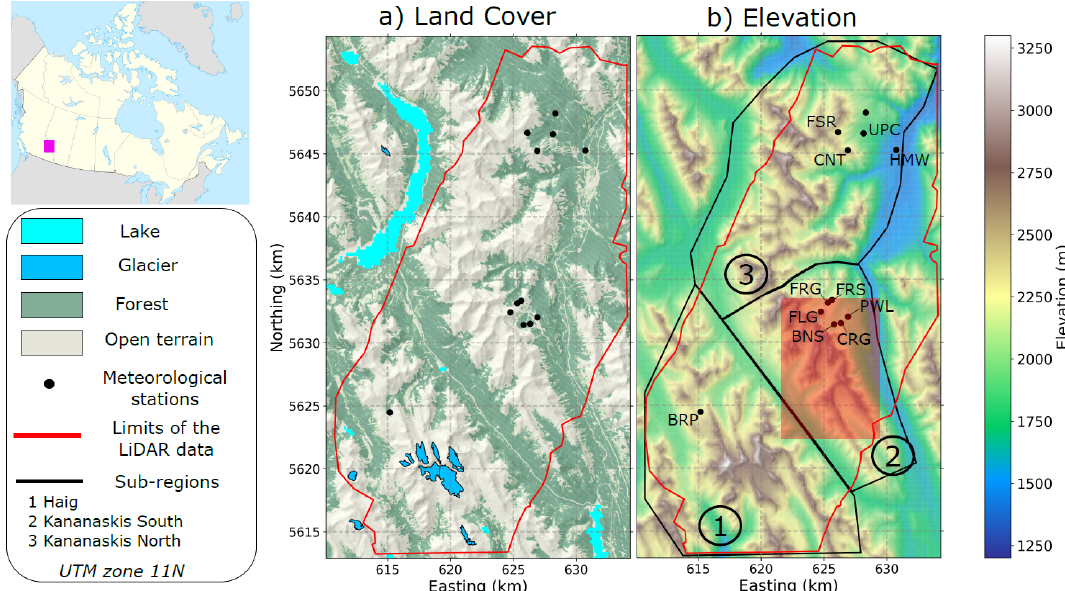
Figure 1. (a) Land cover map and (b) elevation map of the Kananaskis Valley, Alberta, Canada, study domain. The glacier mask is taken from the Randolph Glacier Inventory version 6.0 (Pfeffer et al., 2014). The red-shaded area corresponds to the area shown in Figs. 2, 3, 6 and 10. The characteristics of the meteorological stations are given in Table 3. Areas labelled from 1 to 3 correspond to sub-regions used in the analysis of the results (see Sect.